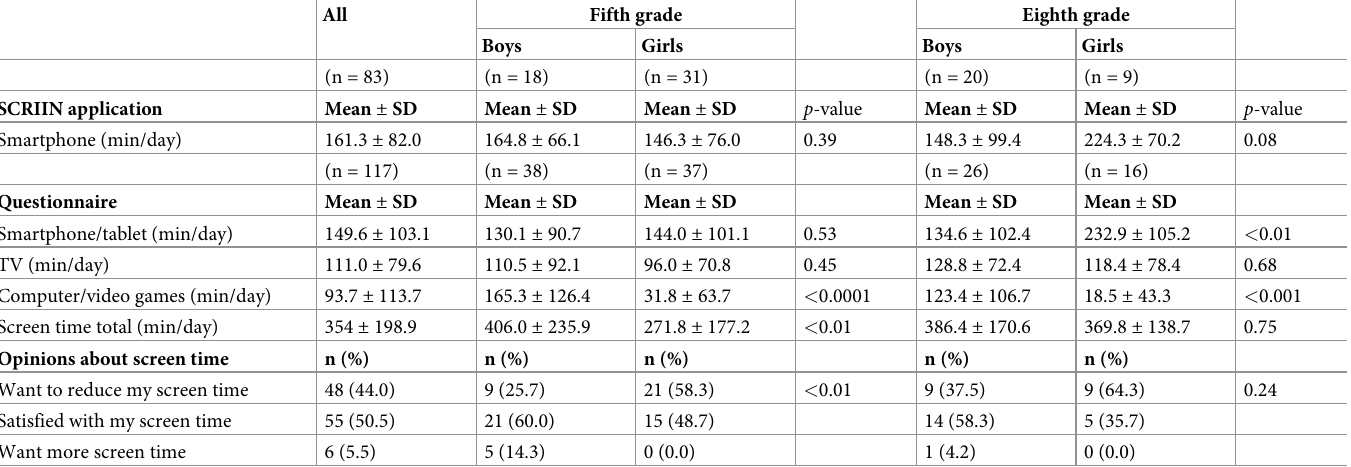
Table 3. Screen time from SCRIIN application and questionnaire, all and stratified by grade and sex.